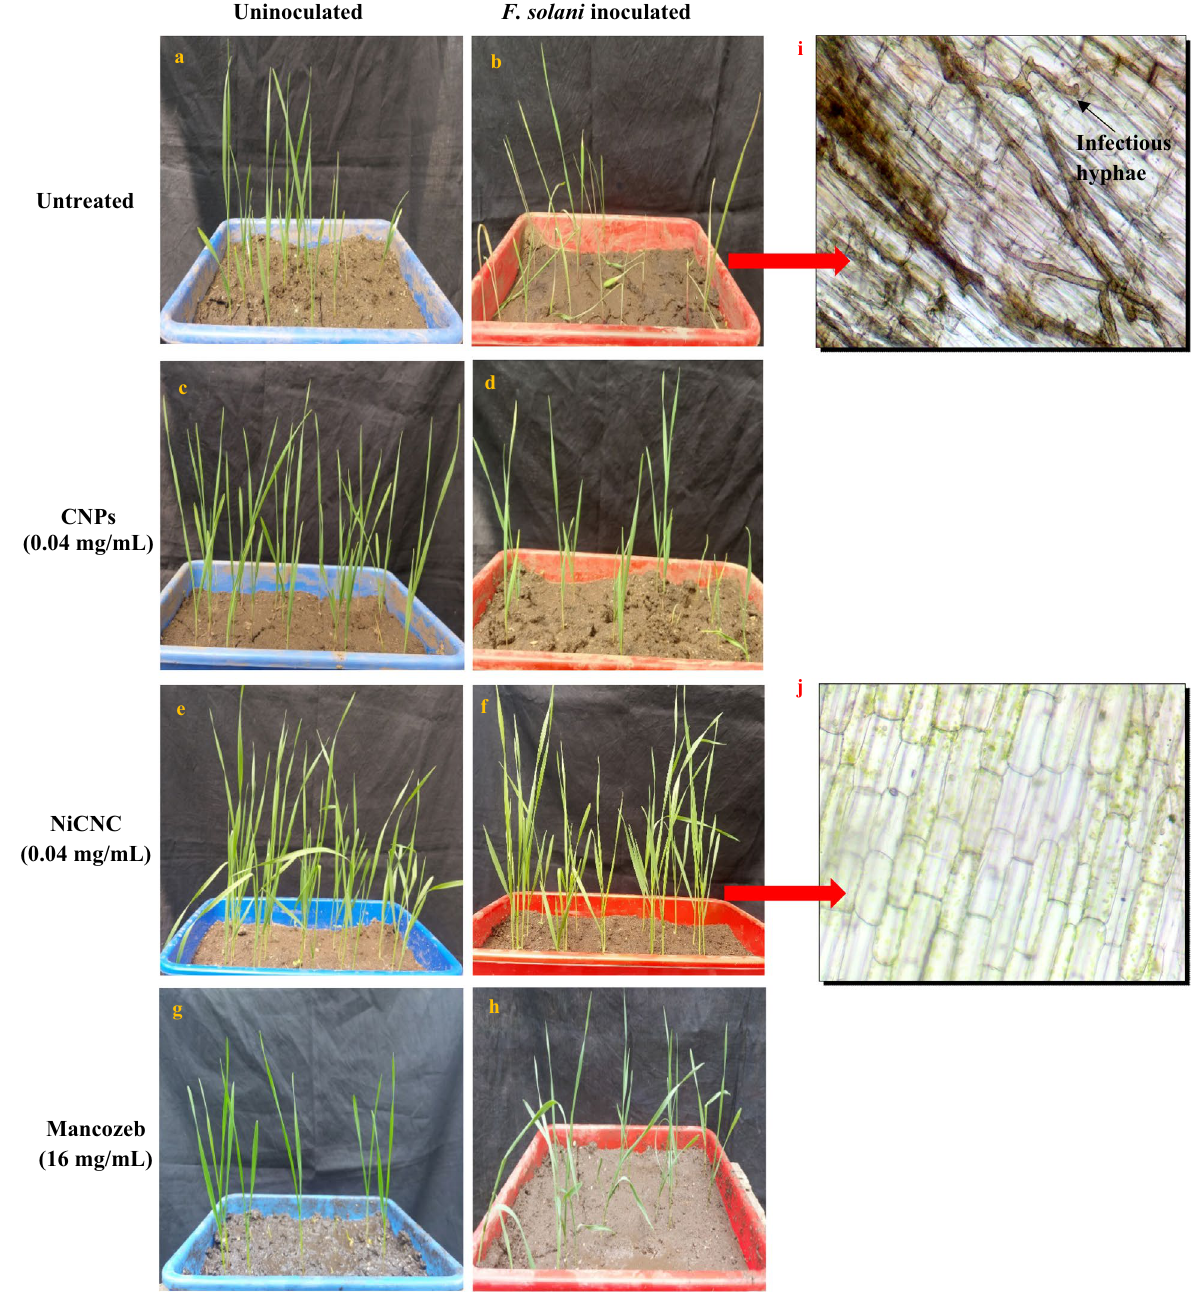
Figure 6. Disease symptoms of uninoculated and F. solani inoculated wheat seedlings at 20th day, exposed to ( a , b ) distilled water (untreated), ( c , d ) CNPs (0.04 mg/mL), ( e , f ) NiCNC (0.04 mg/mL) and ( g , h ) Mancozeb (16 mg/mL); ( i ) longitudinal section of stem of the distilled water treated and F. solani inoculated diseased seedling and ( j ) NiCNC treated and F. solani inoculated seedling. Infectious hyphae were observed to ramify only within the tissues of untreated